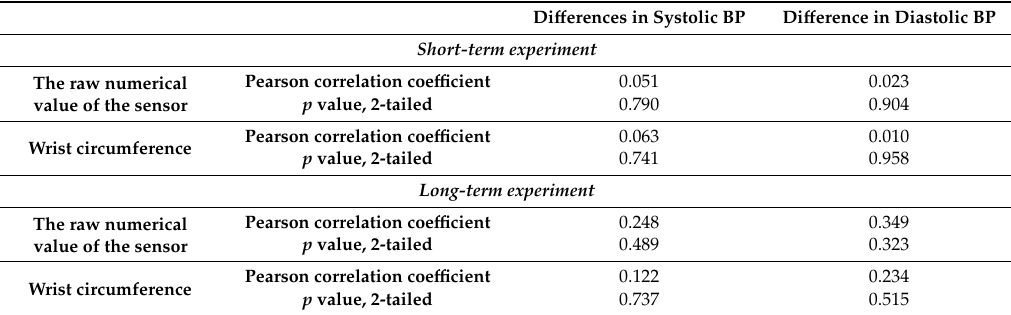
Table 2. Correlations of degree of pressure on radial artery and wrist circumference with di ff erence between calibrated BP and the cu ff -based